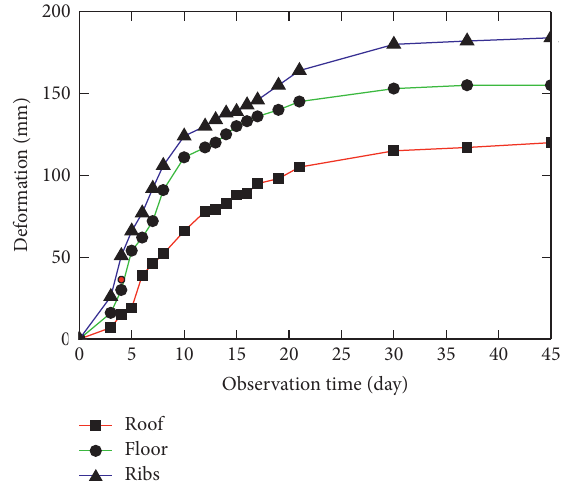
Figure 16: Deformation behavior of the